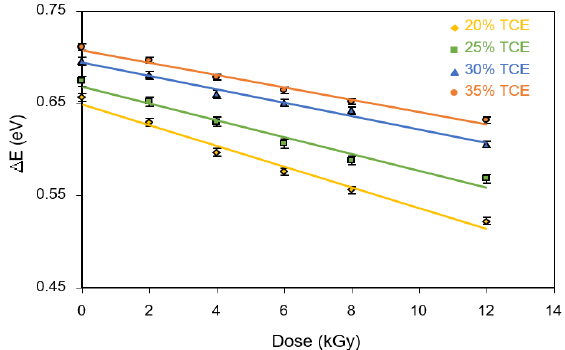
Figure 10. Effect of γ -rays irradiation and TCE composition on the optical activation energy ( Δ E ) of CR dyed PVA-TCE